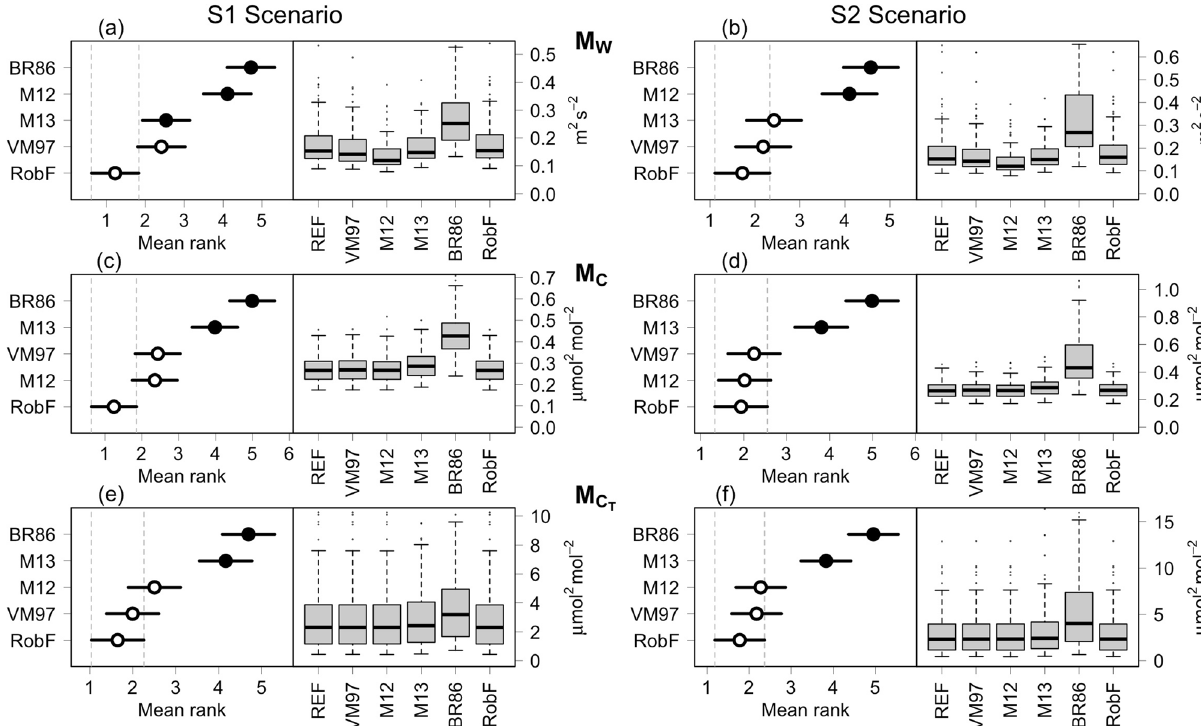
Figure 7. Graphical visualization of the Nemenyi test for the comparison of variance estimates of uncorrupted (REF) and despiked time series according to VM97, M12, M13, BR86 and RobF algorithms. The algorithm with the lowest rank is the best performing, meaning that the difference between variances is the lowest in absolute terms. Panels a and b show the results obtained in S1 and S2 scenarios, respectively, using data simulated from the M W model. Panels c and d show the results obtained in S1 and S2 scenarios, respectively, using data simulated from the M C model. Panels e and f show the results obtained in S1 and S2 scenarios, respectively, using data simulated from the M C T model. White dots indicate there is not statistically significant difference between the results achieved by the despiking algorithms. In all scenarios, the null hypothesis of the Friedman test that there are no significant differences between performances of all the considered algorithms is rejected at 0.05% significance